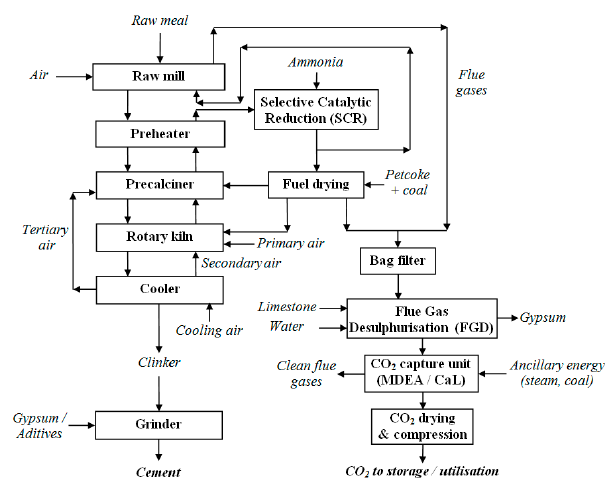
Figure 6. Decarbonized cement plant.